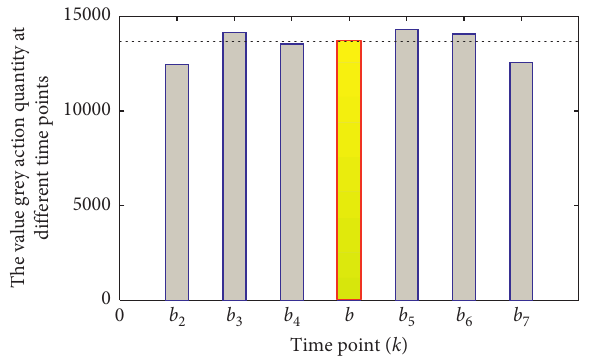
Figure 6: Grey action quantity at different time